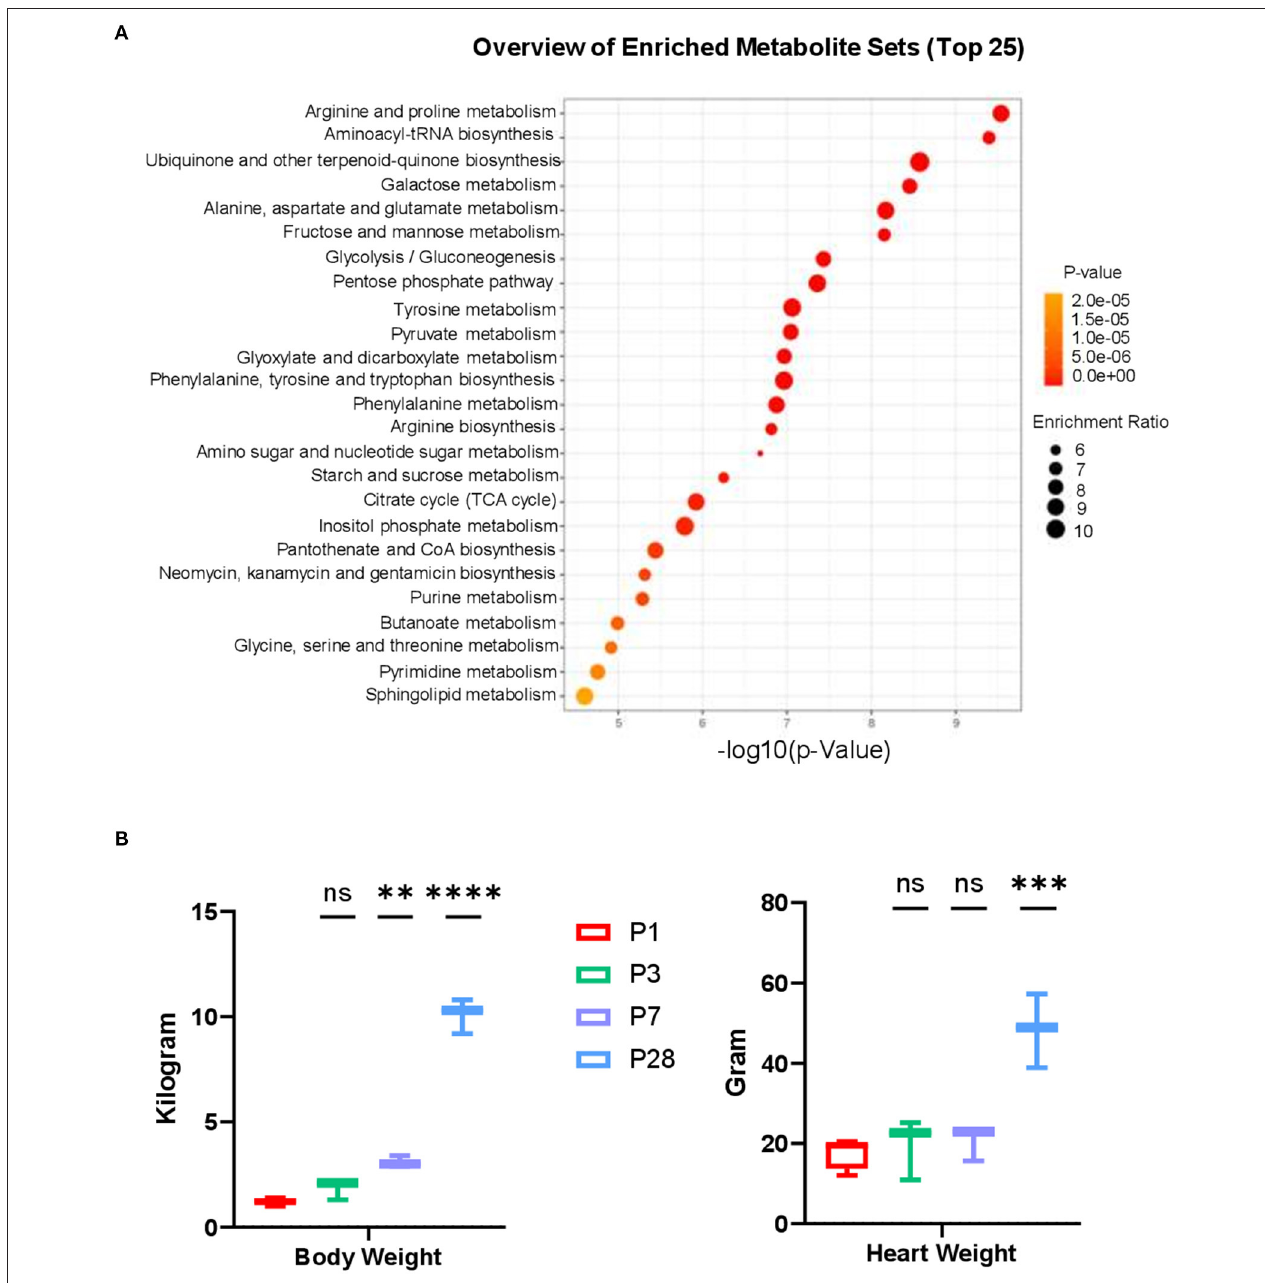
FIGURE 4 | Metabolic pathway analysis and cardiac attributes in neonatal pig hearts. (A) Metabolite set enrichment analysis on metabolites in the P1 and P28 hearts. (B) Body weight and Heart weight in the P1–P28 animals. ** p < 0.01, *** p < 0.001, **** p < 0.0001, one-way ANOVA with Tukey’s Honestly Significant Difference Test. n = 6 hearts per